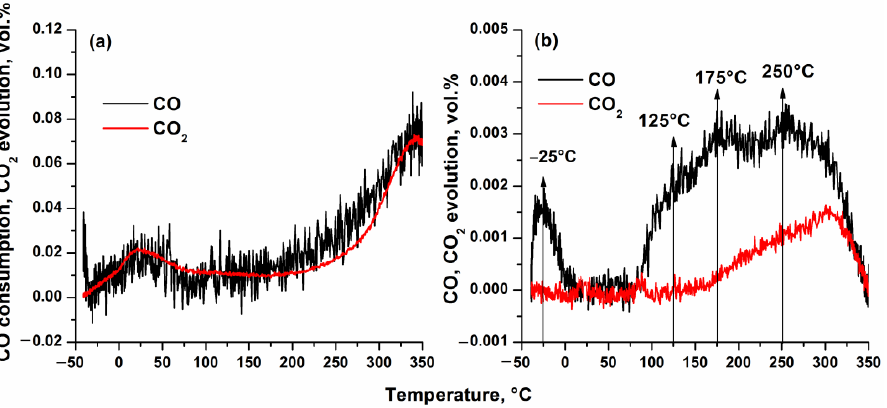
Figure 6. The Pt-C catalyst. ( a ) Temperature dependencies of CO consumption and CO 2 evolution during TPR-CO experiments; ( b ) Temperature dependencies of CO and CO 2 evolution during TPD-CO experiments. The reaction mixture contains 1.0 vol.% CO, 0.5 vol.% Ne, and He balance. The reaction mixture rate was 100 cm 3 /min. The heating rate was 10 °C/min. TPR-CO: The heating was carried out in the reaction mixture. TPD-CO: After the initial CO concentration (1 vol.% CO) was reached, the CO supply was turned off, followed by helium supply at − 40°C for 2 h. The heating was carried out in helium.